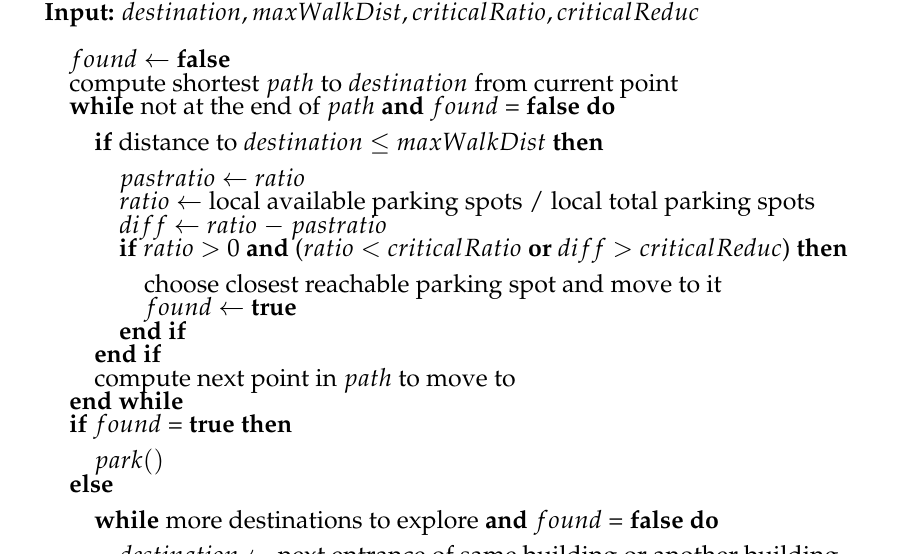
Algorithm 1: Explorer agents decision